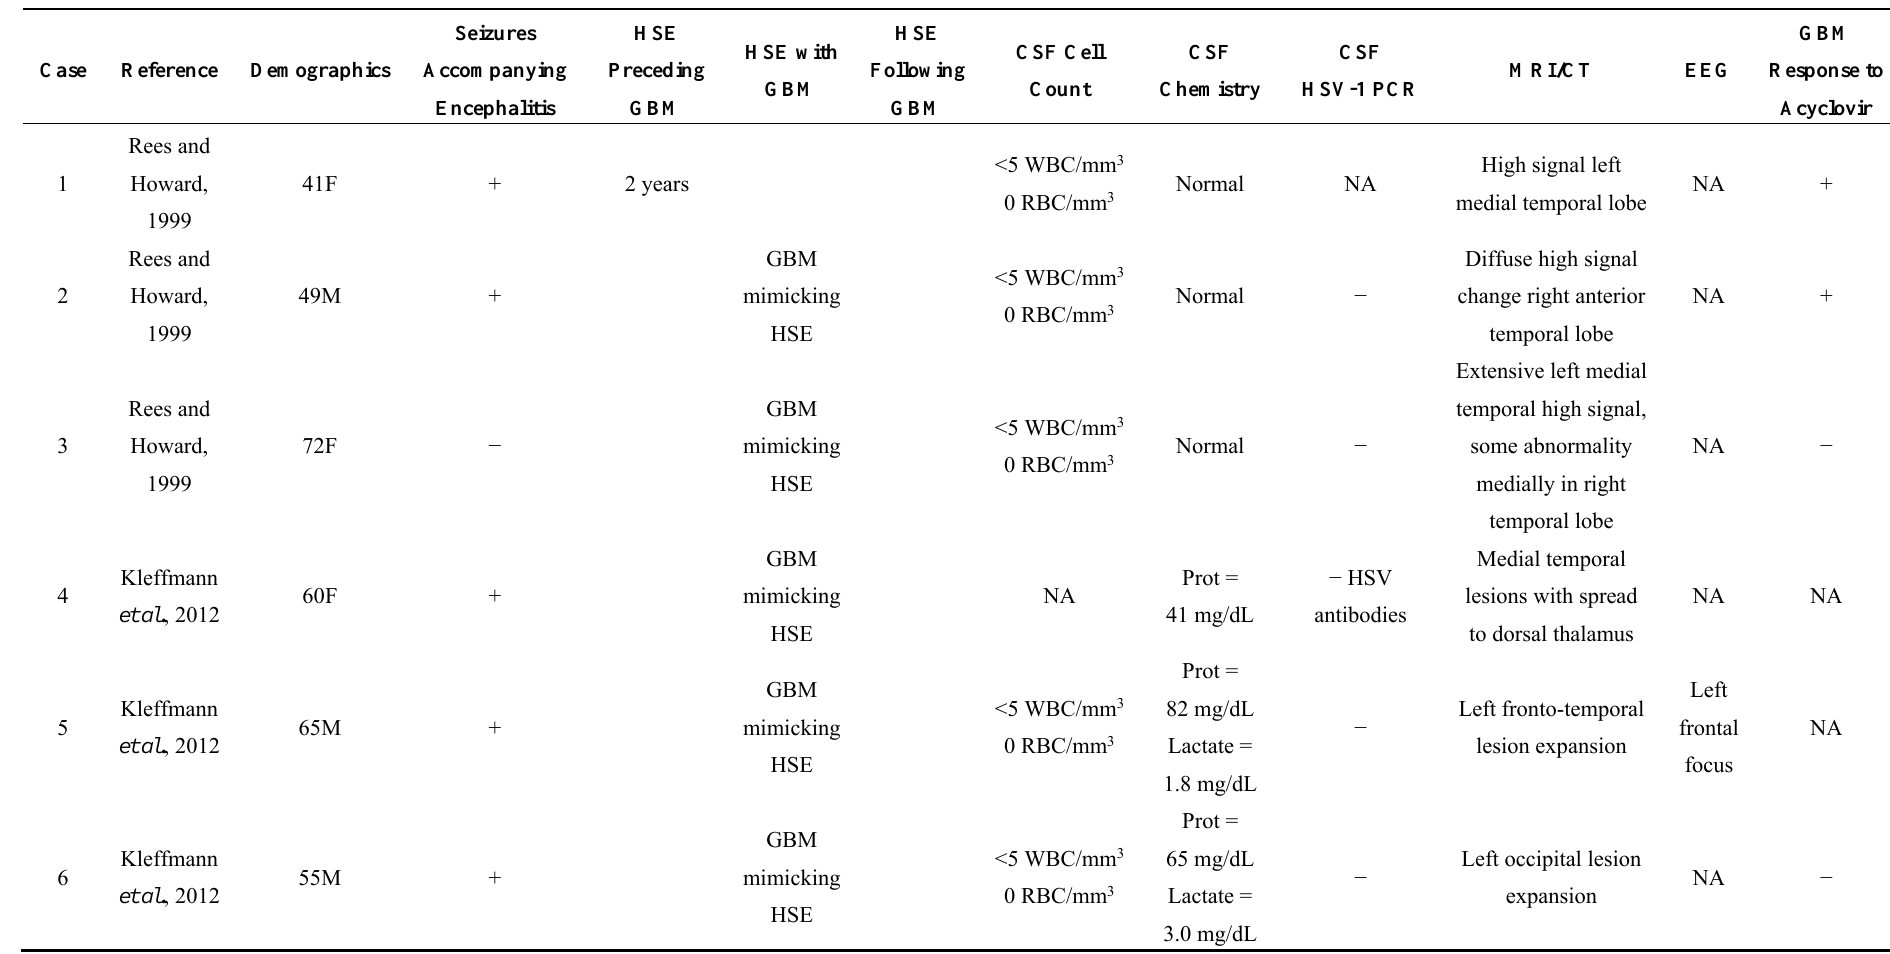
Table 1. Clinical and laboratory features of glioblastoma multiforme (GBM) cases complicated by herpes simplex virus-1 (HSV-1) encephalitis (HSE).